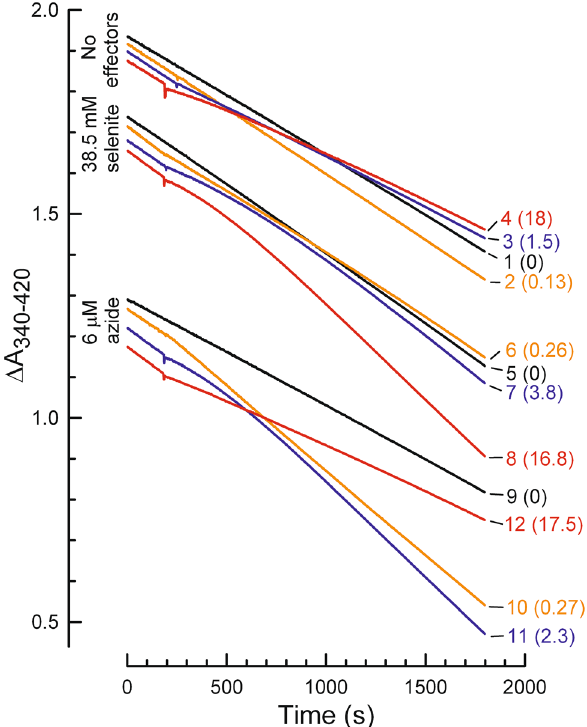
Figure 1. Venturicidin A has complex effects on ATPase kinetics of WT E. coli membranes . ATP hydrolysis was assayed as described in “Methods”. As noted beside the vertical axis, an additional effector was present initially for traces 5–8 (38.5 mM selenite) and 9–12 (6 µM azide). At 200 or 300 s, ventA was added to some assays; for each numbered trace, the final ventA concentration (μM) is in parentheses on the right, in the same color as the trace. Membrane protein per 1 ml assay: 3.36 µg ( traces 1–4 ), 1.47 µg ( traces 5–8 ) or 7.35 µg ( traces 9–12 ). For each set of assay conditions (± selenite or azide), the specific ATPase activity (U/mg membrane protein) before adding ventA is listed in Table 1 under “100%